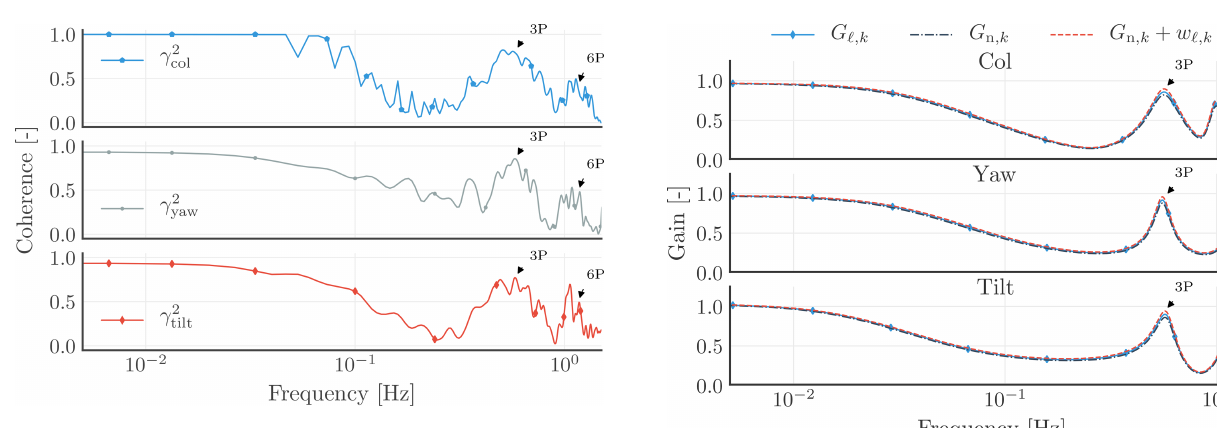
Figure 13. Coherences ( γ 2 ) between the blade effective wind speeds ( u beff ,k ) and the corrected inflow wind speeds ( u cor ,k ) in the non-rotating frame of reference, with k ∈ { col, yaw, tilt } .